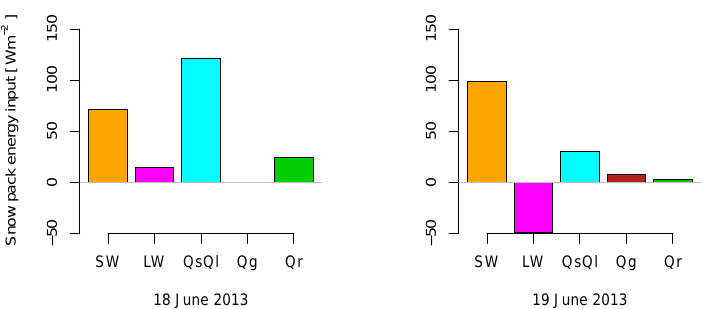
Figure 7. Snow energy balance flux partition. SW is net shortwave radiation, LW is net long wave radiation, QsQl is turbulent heat interchange with the atmosphere, Qg is heat transfer from the subsurface and Qr is advection of heat due to rain. Following convention, positive indicates flux towards the snow and negative flux is energy leaving the snowpack.